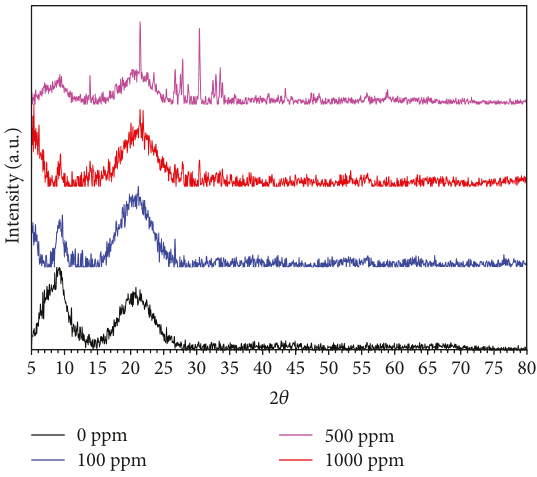
Figure 7: DRX pattern of chitosan fi lms doped with Nd nanoparticles.